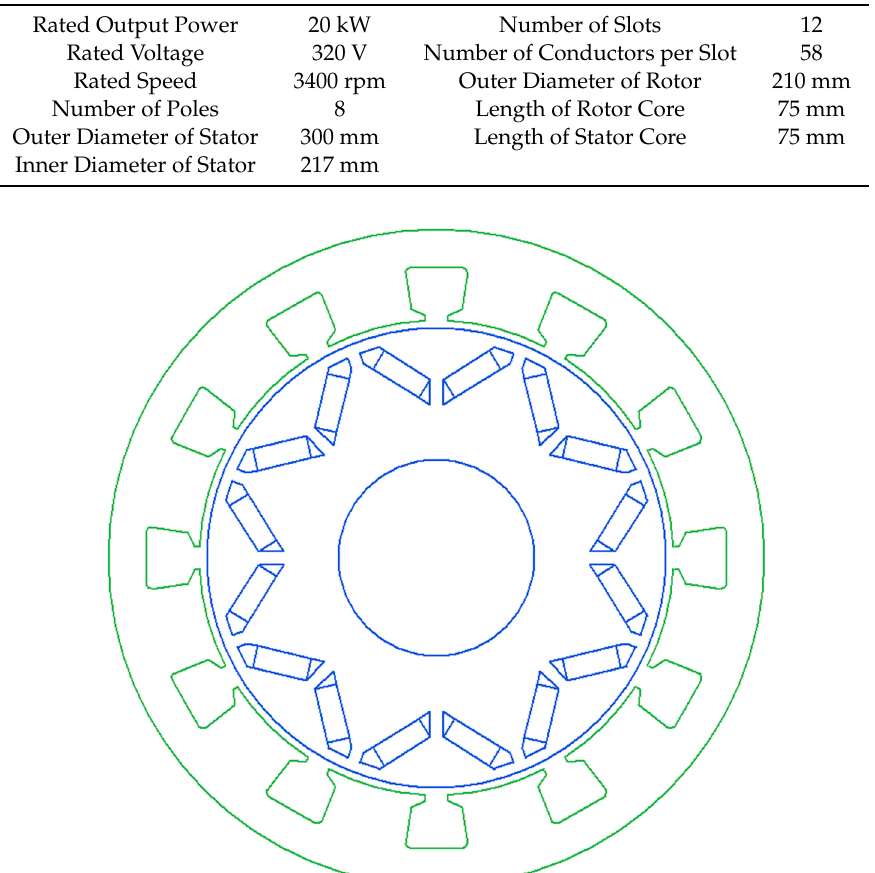
Figure 2. Cross-section through the IPMSM with magnets in V-arrangement used in the validation of the analytical method for calculating the reluctance torque. Table 2. Magnetic parameters to validate the analytical calculation of reluctance torque for